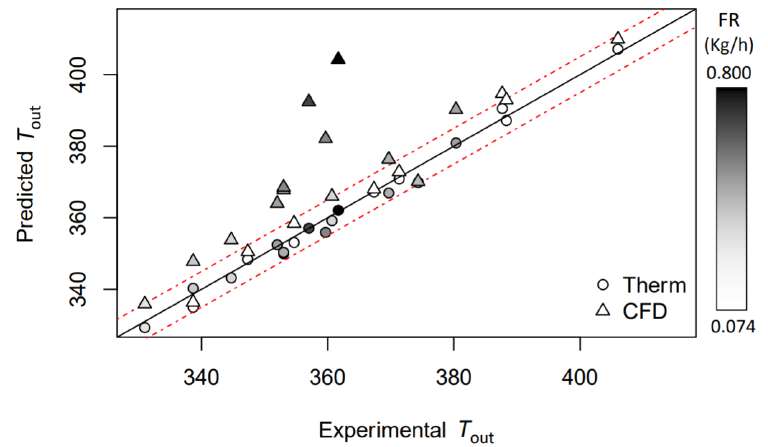
Figure 5. Comparison between predicted and observed values for the atomizing data set. Error bands dashed in red at ± 5 K from the reference value (solid black line). Table 3. Model evaluation metrics on T out